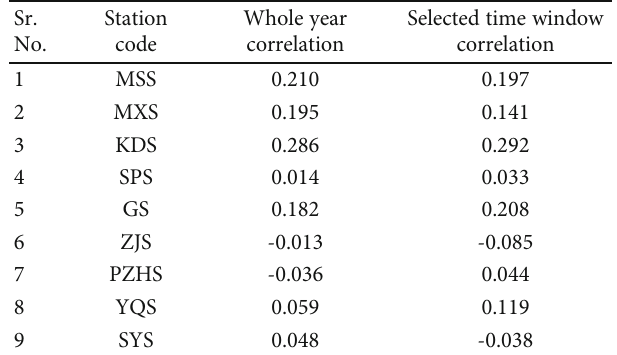
(Table 1; Figures 3(h) and 3(i)). Based on the results of